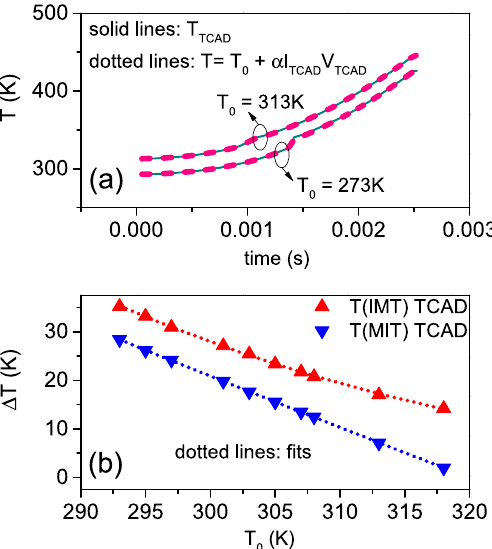
Figure 4. ( a ) Local temperatures probed in the geometrical center of the device as extracted by TCAD simulations (dark cyan solid lines) for T 0 equal to 293 and 313 K. We achieve a very good agreement with temperatures calculated after Eq. (4) for α = 5.15 × 10 5 K / W (pink dashed lines). ( b ) (cid:31) T IMT (red triangles) and (cid:31) T MIT (blue triangles) as determined by TCAD simulations for different T 0 . The dotted lines are the correspondent fits by 2nd order